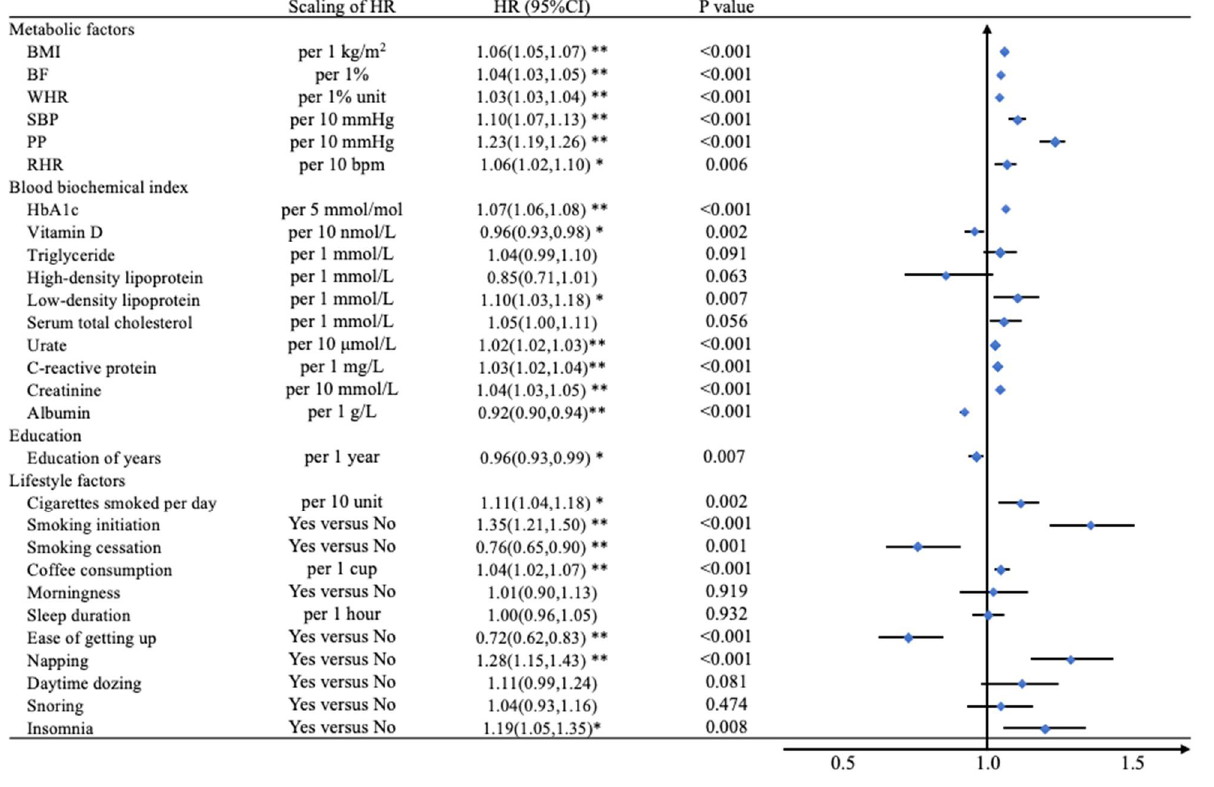
Figure 2. The hazard ratio of modifiable risk factors and AVS incident patients. Adjusted by age, sex, family history of cardiovascular disease, family history of diabetes, education, household income, and Townsend deprivation index. * p -value less than 0.05 ( p < 0.05); ** p -value less than 0.0018 ( p < 0.05/28) for Bonferroni correction. The models adjusted for gender, age, education, income, Townsend deprivation index, family history of cardiovascular disease and diabetes, metabolic equivalent of physical activity, alcohol daily consumption, smoking status, and systolic blood pressure. Biochemical indices were further adjusted by cholesterol-lowering medication.